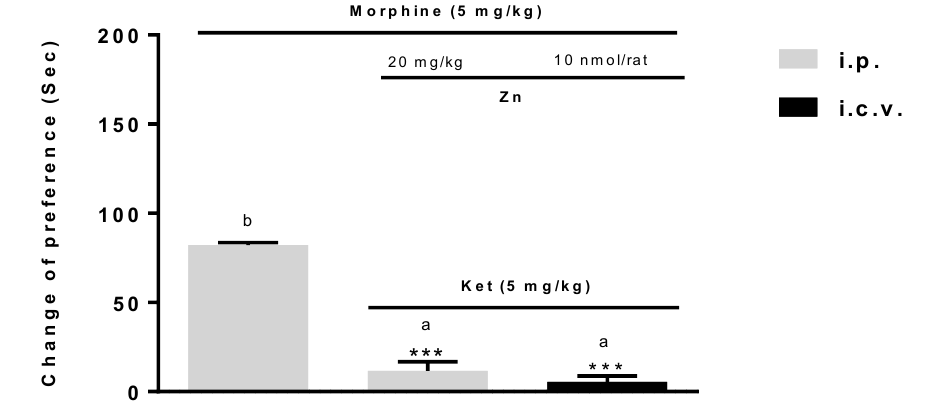
Figure 8. Effect of Ketanserin on the enhancement effect of Zn on the expression of morphine-induced CPP. Zn was given i.p. (20 mg/kg) and i.c.v. (10 nmol/rat) separately after the ketanserin treatment in the post-conditioning sections. Each point represents the mean± SEM of six rats. *** Presents significant between saline (10 ml/kg, IP) group at p < 0.001. Different letters indicate significant differences between groups (p<0.05) (Tukey’s post-hoc test).Zn=Zinc, and Ket= Figure 8. Figure 8.